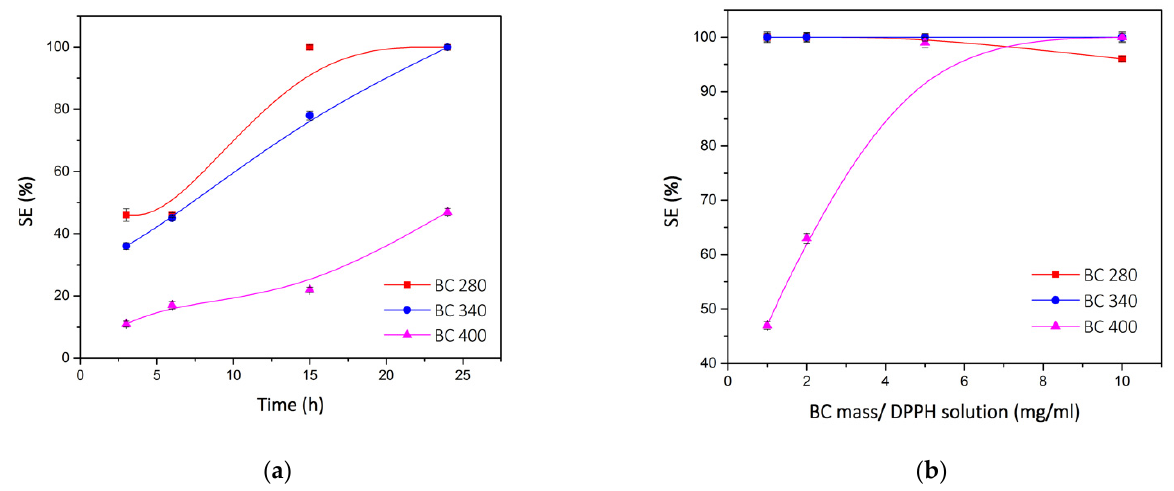
Figure 3. Scavenging efficiency of ( a ) 1 mg/mL of solid as function of time (left) and ( b ) varying the content of solid in DPPH solution after 24 h (right).